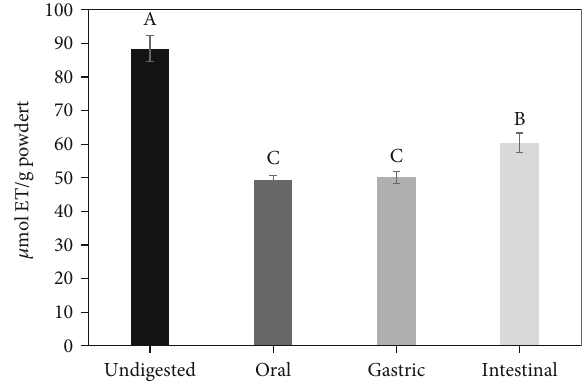
Figure 3: Total phenolic content of microencapsulated extracts during the in vitro digestion